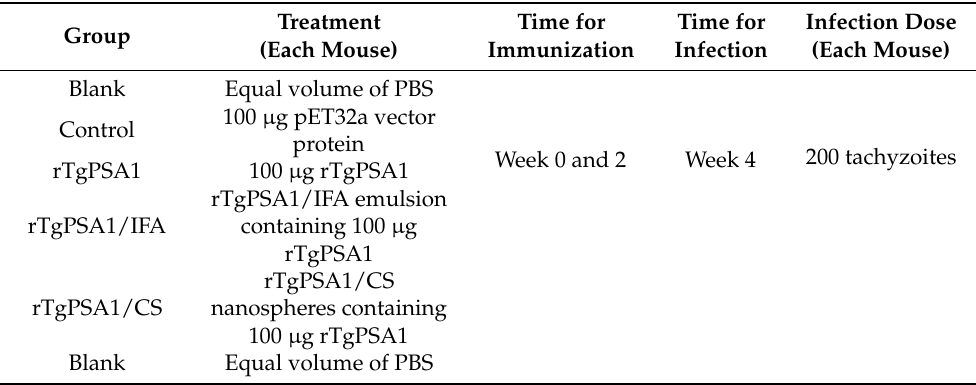
Table 1. Immunization formulations in different mouse